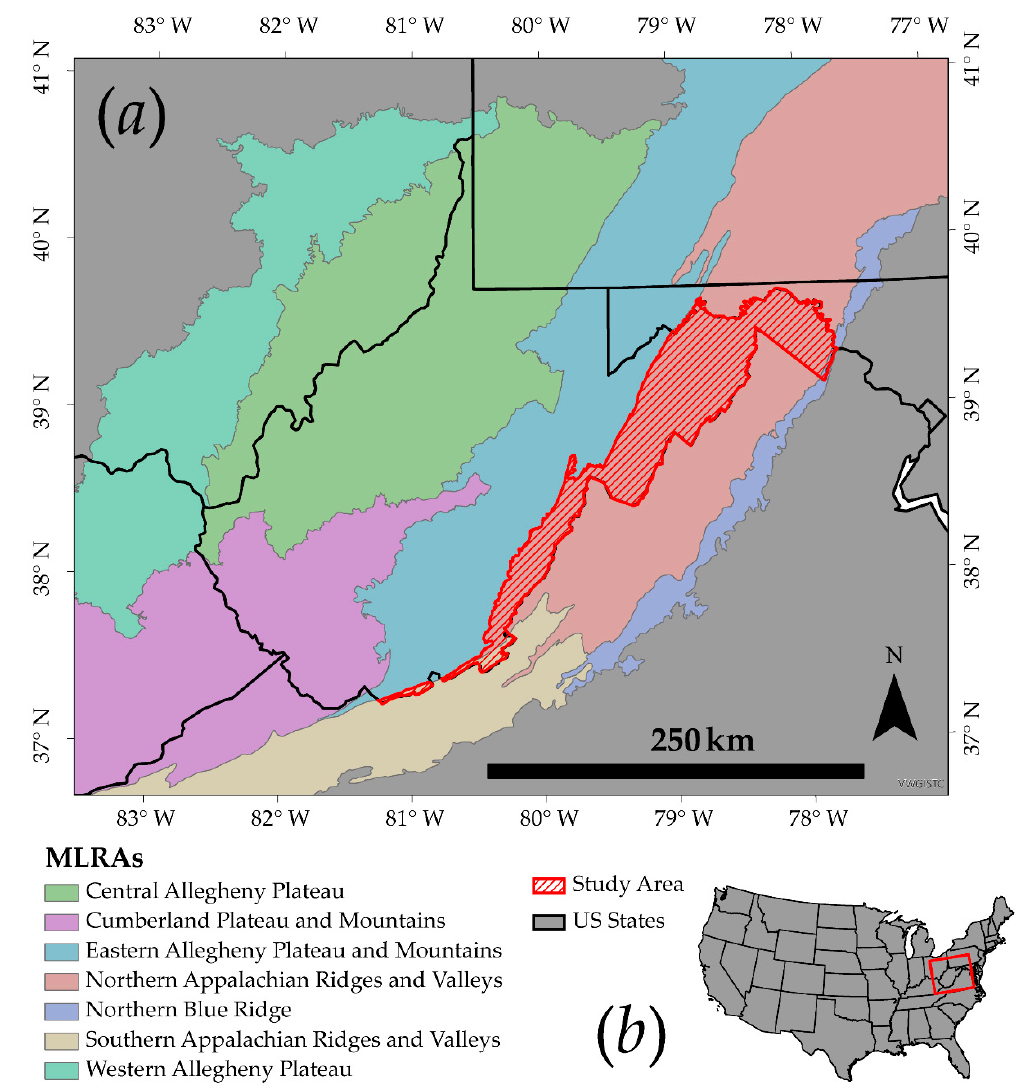
Figure 1. ( a ) Study area extent defined by Northern Appalachian Ridges and Valleys Major Land Resource Area (MLRA). ( b ) Location of study area within United States. MLRA boundaries were obtained from the Natural Resources Conservation Service (NRCS) of the United States Department of Agriculture (USDA).